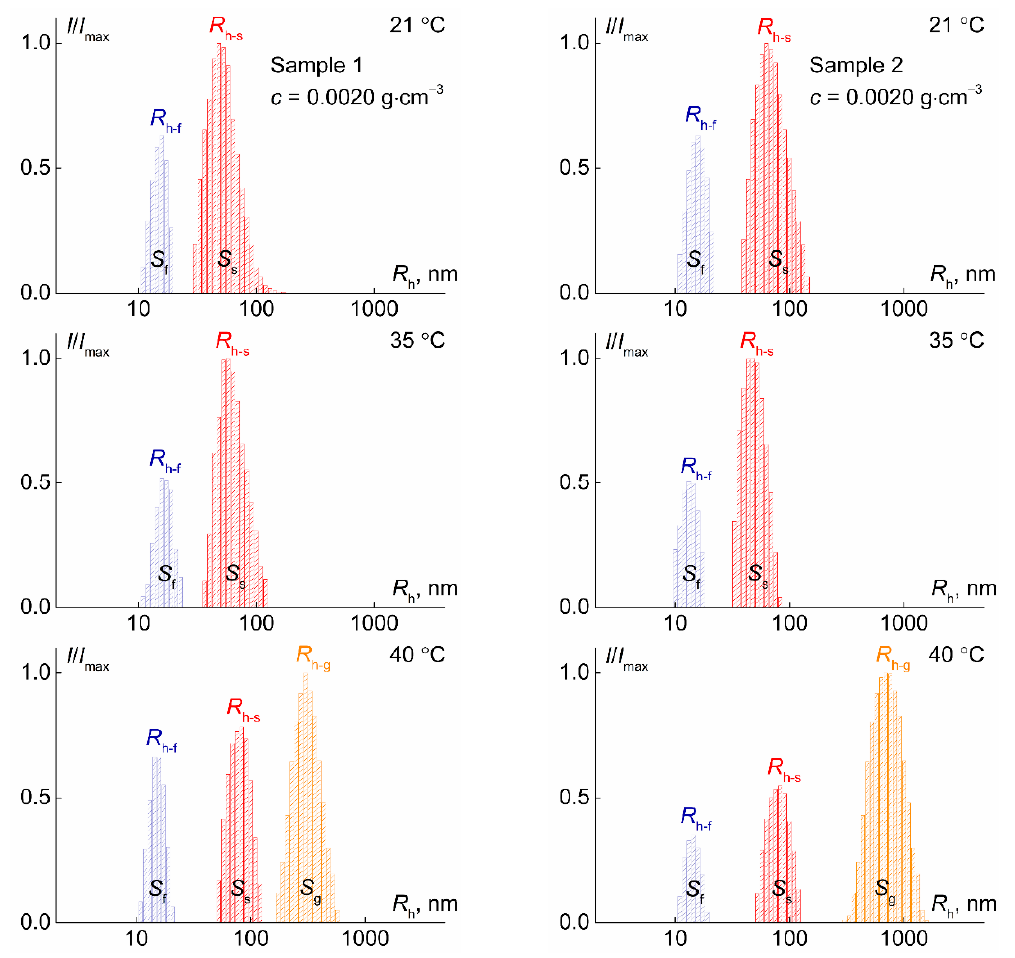
Figure 4. The dependences of relative intensity I / I max of scattered light on the hydrodynamic radius R h of scattering species for PDMS- g -PiPrOx solutions.